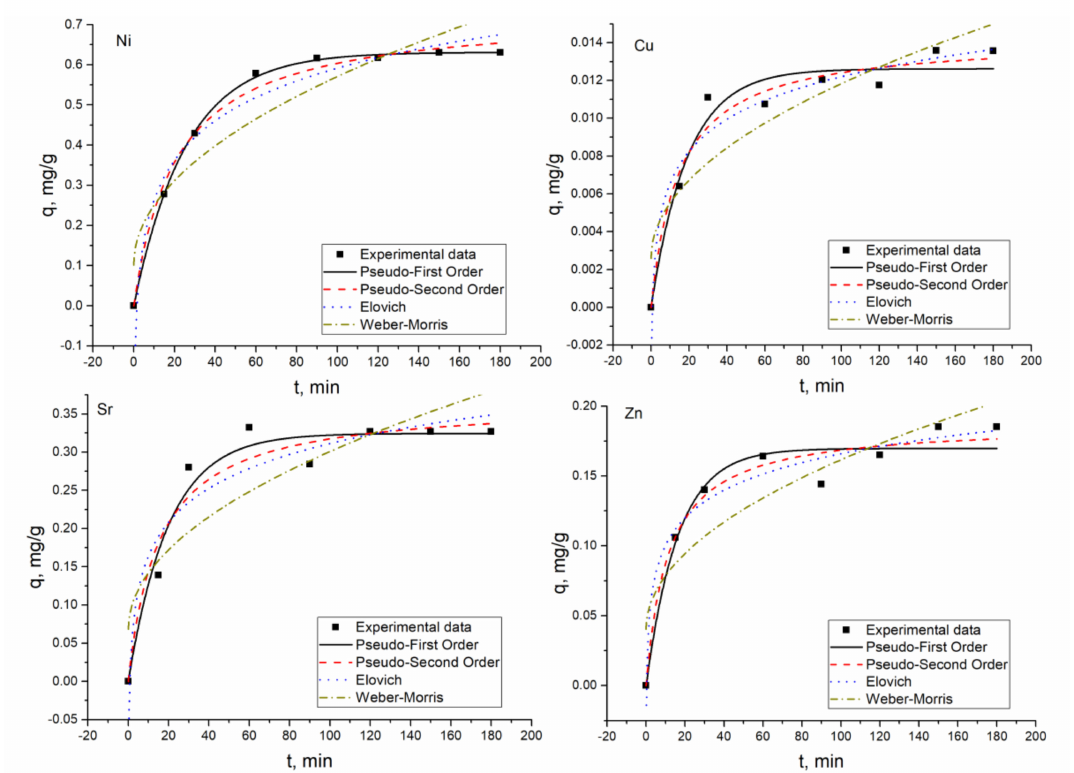
Figure 6. Metal adsorption on hybrid adsorbent in Ni(II)-Sr(II)-Cu(II)-Zn(II) system.